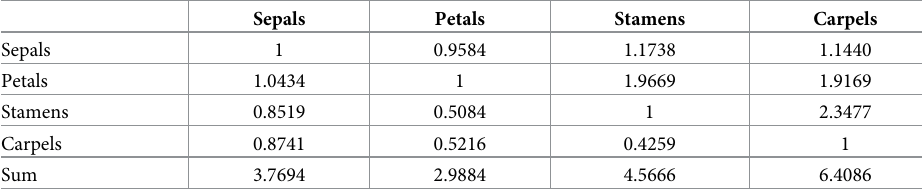
Table 3. Sum of W1-W6 value.